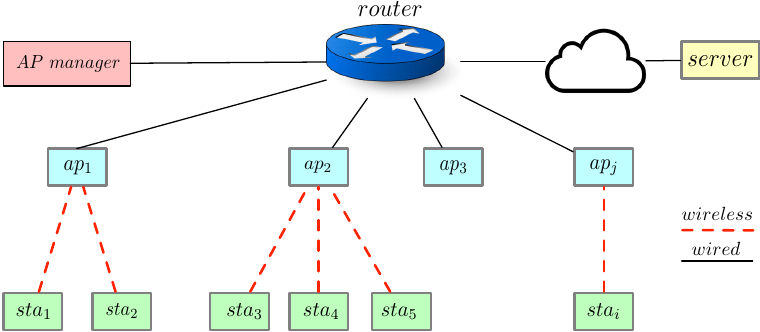
Figure 1. The overall system architecture. Stations are connected with their associated APs. APs are connected to an AP manager through one or multiple